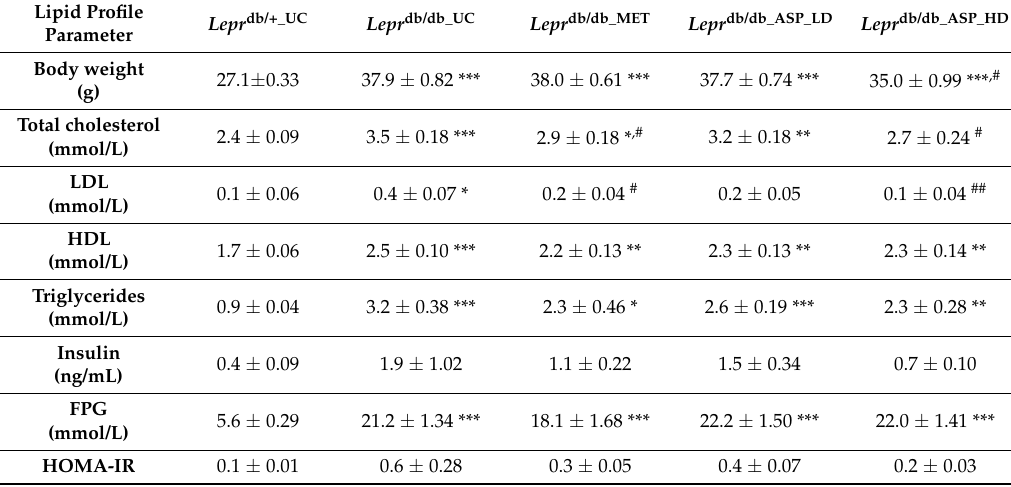
Table 1. Effect of aspalathin on blood lipid profiles and